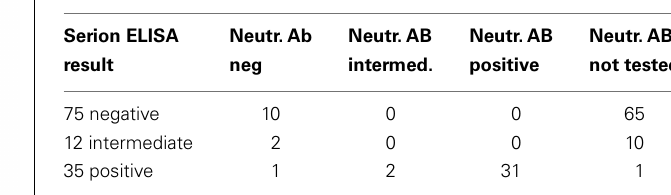
Table 3 | Comparison of standard ELISA for anti-TBE IgG vs. neutralizing antibodies